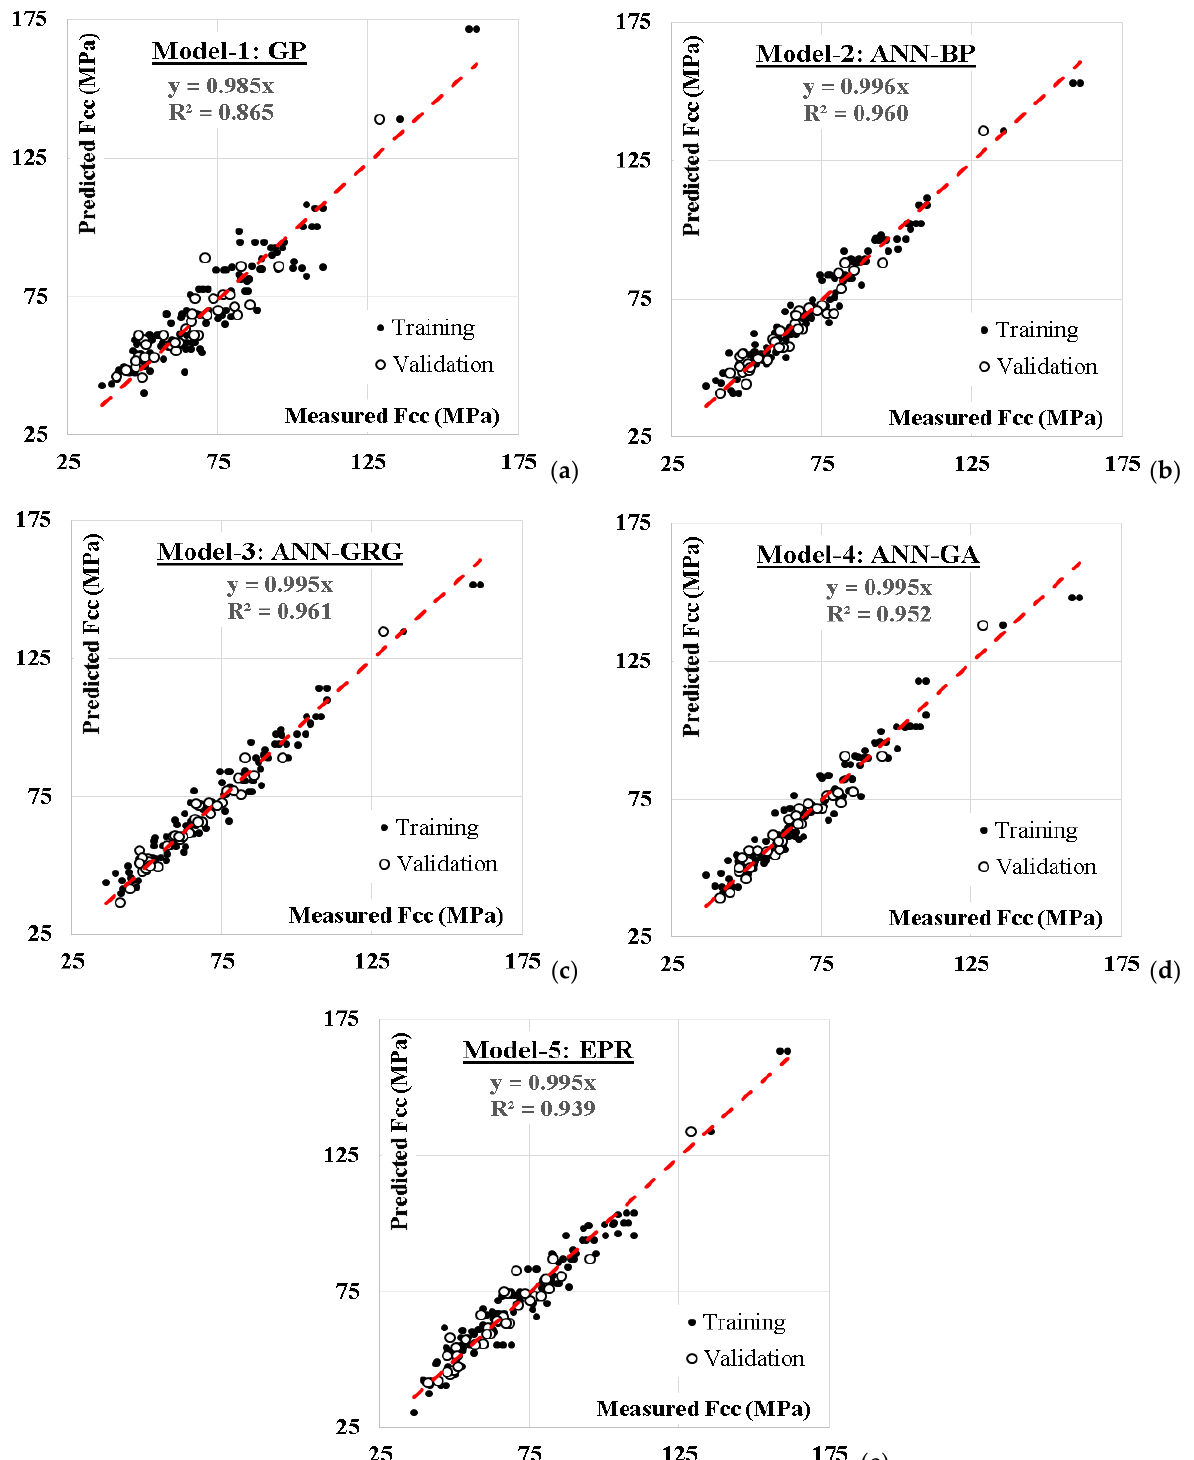
Figure 5. Relation between predicted and calculated F cc values using the developed models. ( a ) Using GP, ( b ) using ANN-BP, ( c ) using ANN-GRG, ( d ) using ANN-GA, and ( e ) using EPR.